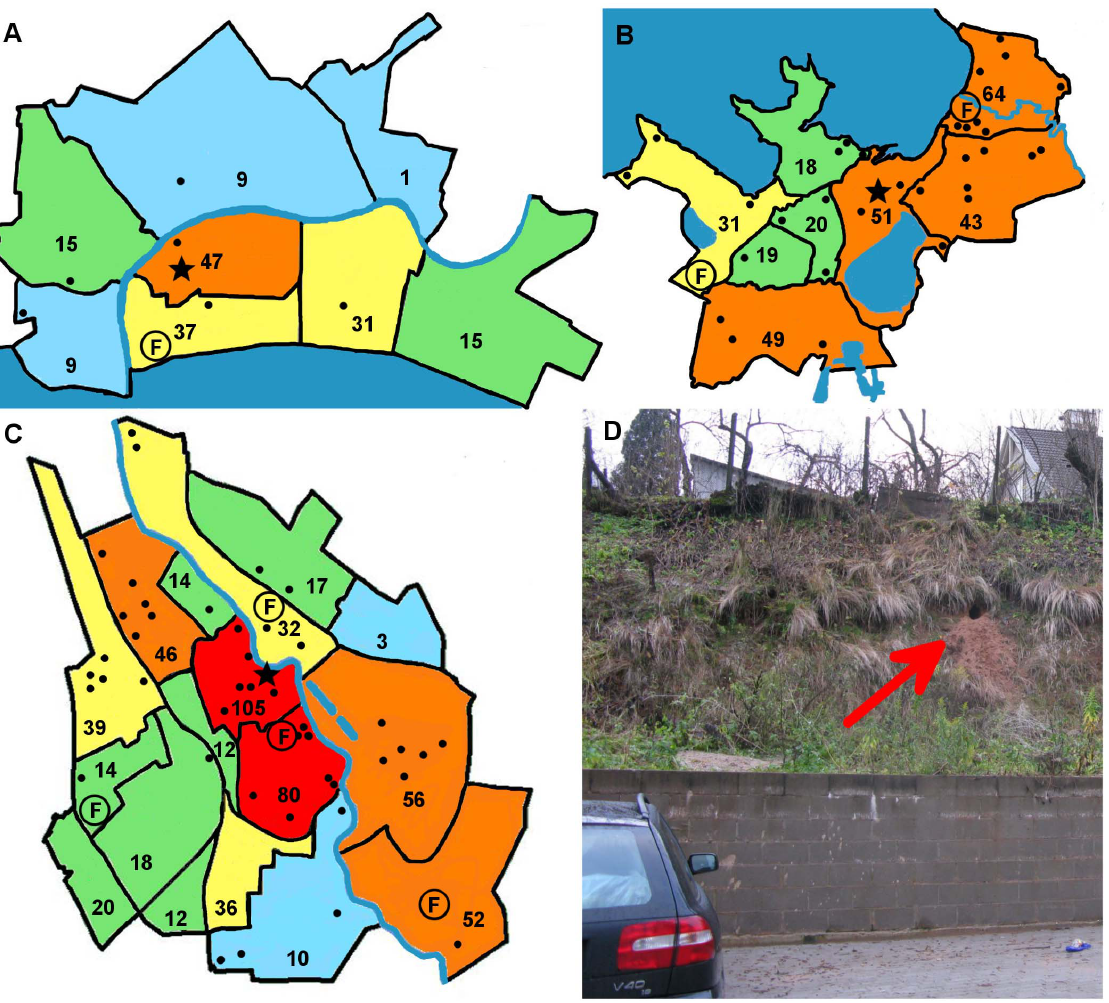
Fig. 2. Distribution of foxes in the three largest cities in Estonia: Pa¨rnu (A), Tallinn (B) and Tartu (C), and a photo of a fox den in the central part of Tartu (D, indicated by arrow). The city centre is denoted by a black star, and numbers indicate the number of people reporting fox sightings in different parts of the city. The black points indicate reports of foxes exhibiting symptoms of sarcoptic mange. Fox dens are shown by the letter